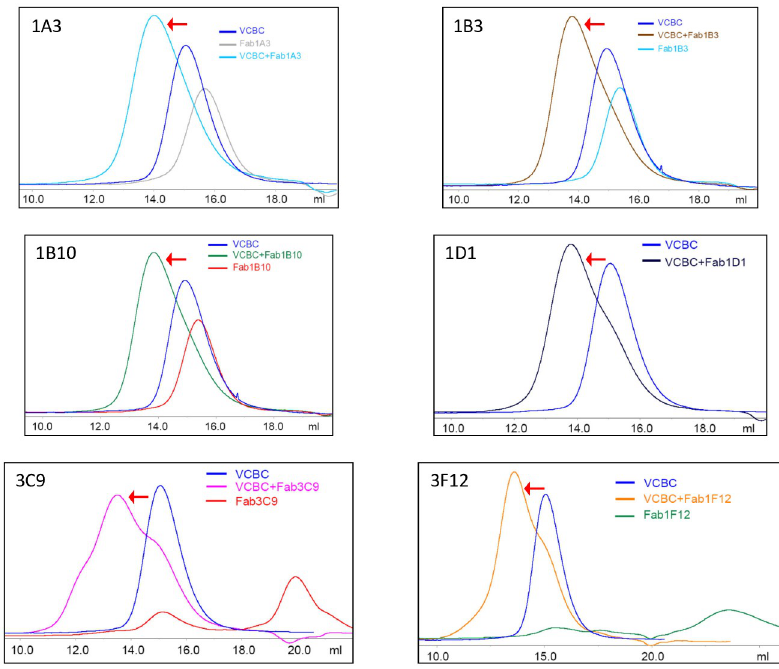
Fig 4. Elution profiles of VCBC complexed with six different Fabs. The mixtures of VCBC and Fab at 1:1 stoichiometry were loaded onto Superdex-200 analytical columns and UV profiles of the eluates were compared to those of VCBC and individual Fabs. X-axis indicates volume (mL) eluted, Y-axis indicated absorbance at 280nm. The shift in elution volume indicates that VCBC forms a stable complex with the Fabs at 1:1 ratio. The elution profile of Fab 1D1 alone is shown in S1